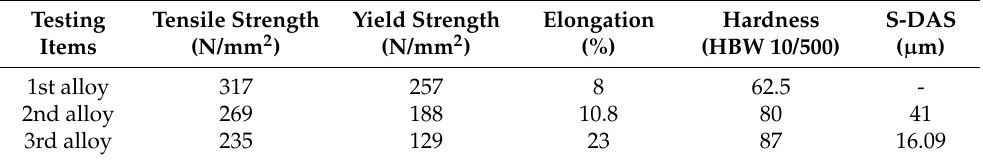
Table 5. Mechanical properties of alloys prepared under different process conditions.